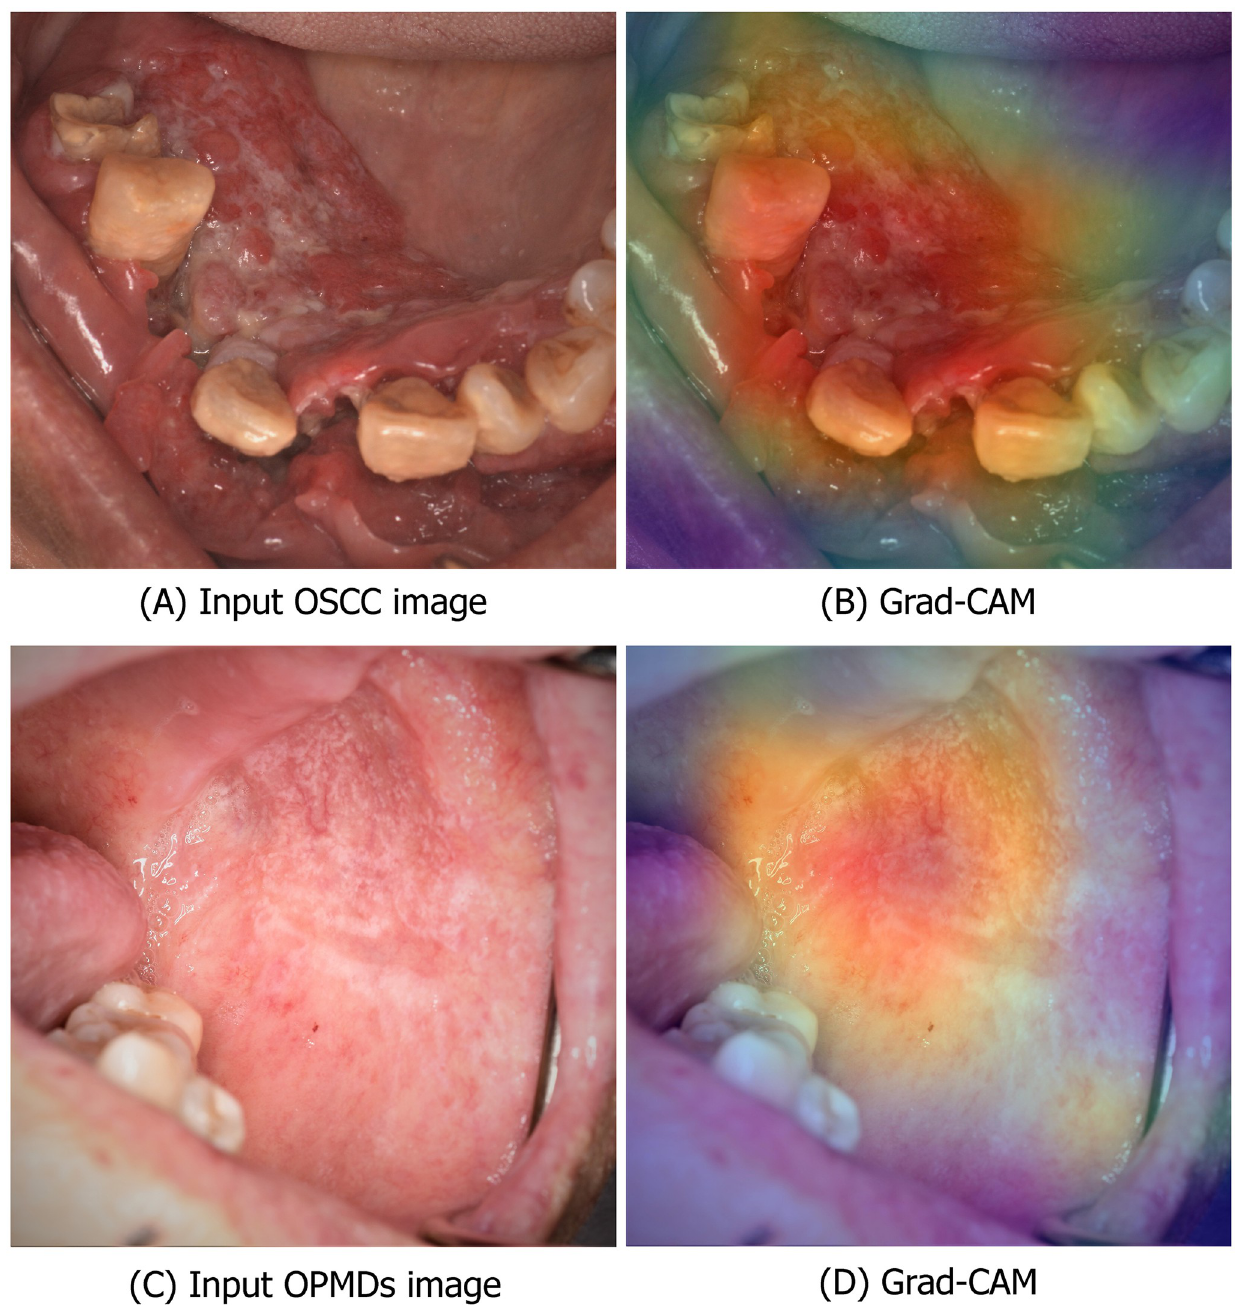
Fig 2. Example of the Grad-CAM visualization of the DenseNet-169. (A) Image with OSCC lesion; (B) The model correctly classified OSCC and labeled the correct location. (C) Image with OPMDs lesion (D) The model correctly classified OPMDs and labeled the correct location.